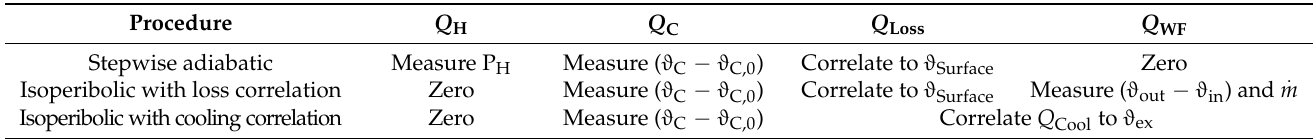
Table 1. Overview of determination of each contribution to heat flow balance equation for different calorimetric measure- ment